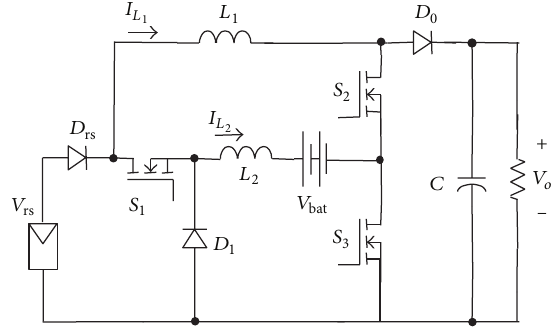
Figure 4: Proposed